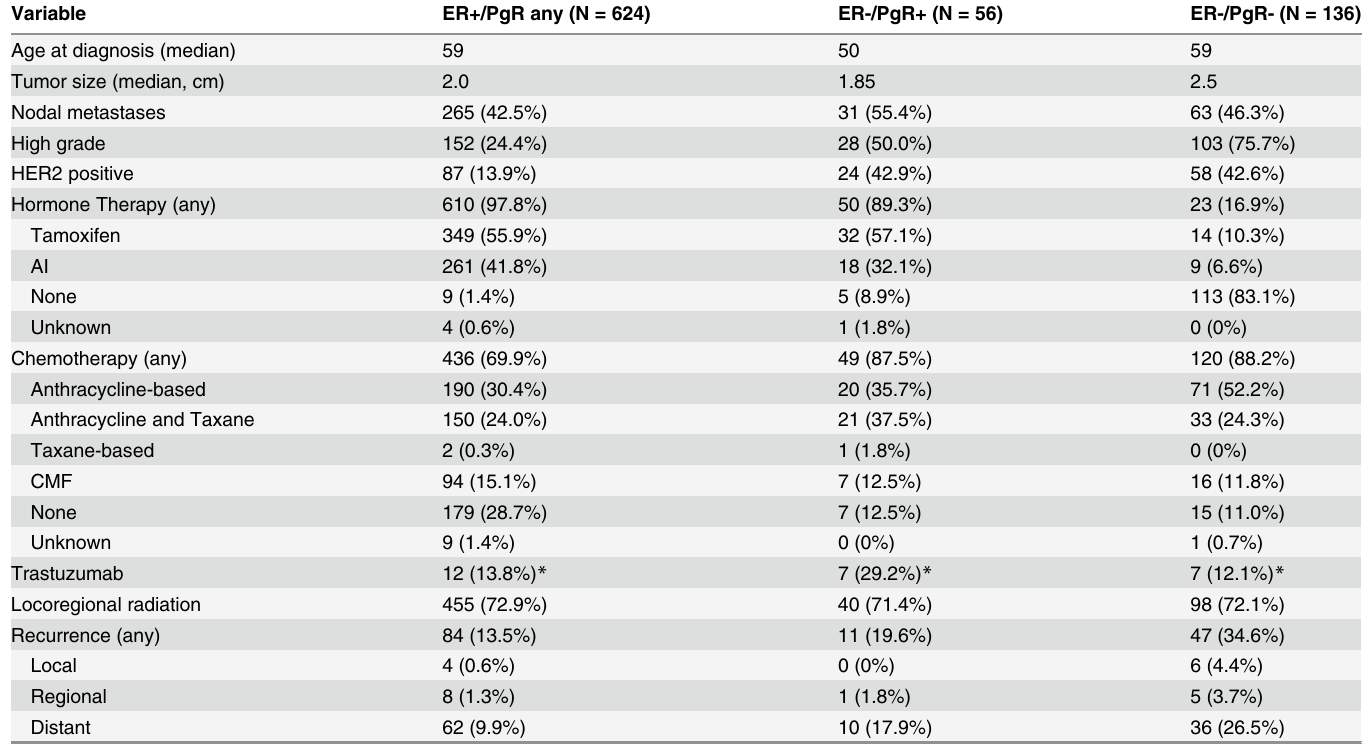
Table 1. Characteristics of included patients by receptor